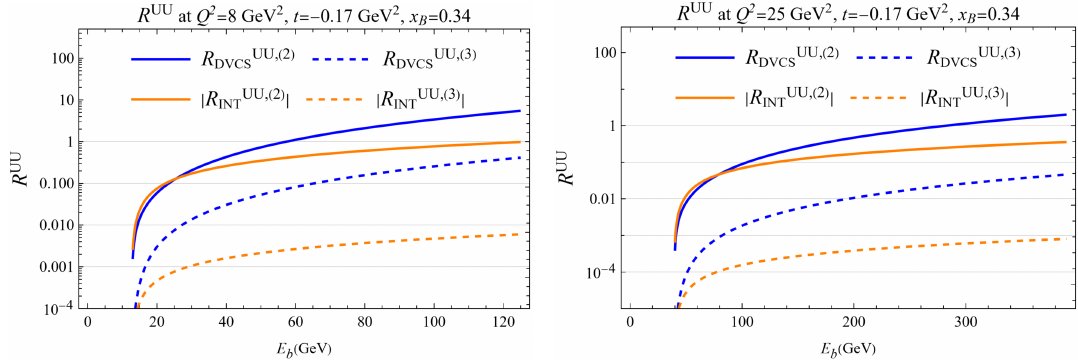
Figure 10 . A comparison of cross-section ratios of Q 2 = 8 GeV 2 (left) and Q 2 = 25 GeV 2 (right) kinematics. The absolute values of them are taken when negative values are encountered, and the CFFs in table 1 are used assuming weak Q 2 dependence of them. While the twist-three ratios (dashed lines) are always suppressed relative to the twist-two ratios (solid lines) due to the fixed large Q 2 , both ratios increase as E b increases, indicating the enhancement of pure DVCS and interference contributions compared with the BH background. Note that the x -axis E can be converted into s b using s = M 2 + 2 ME , which applies to collider kinematics as such the EIC5 × 41 as b